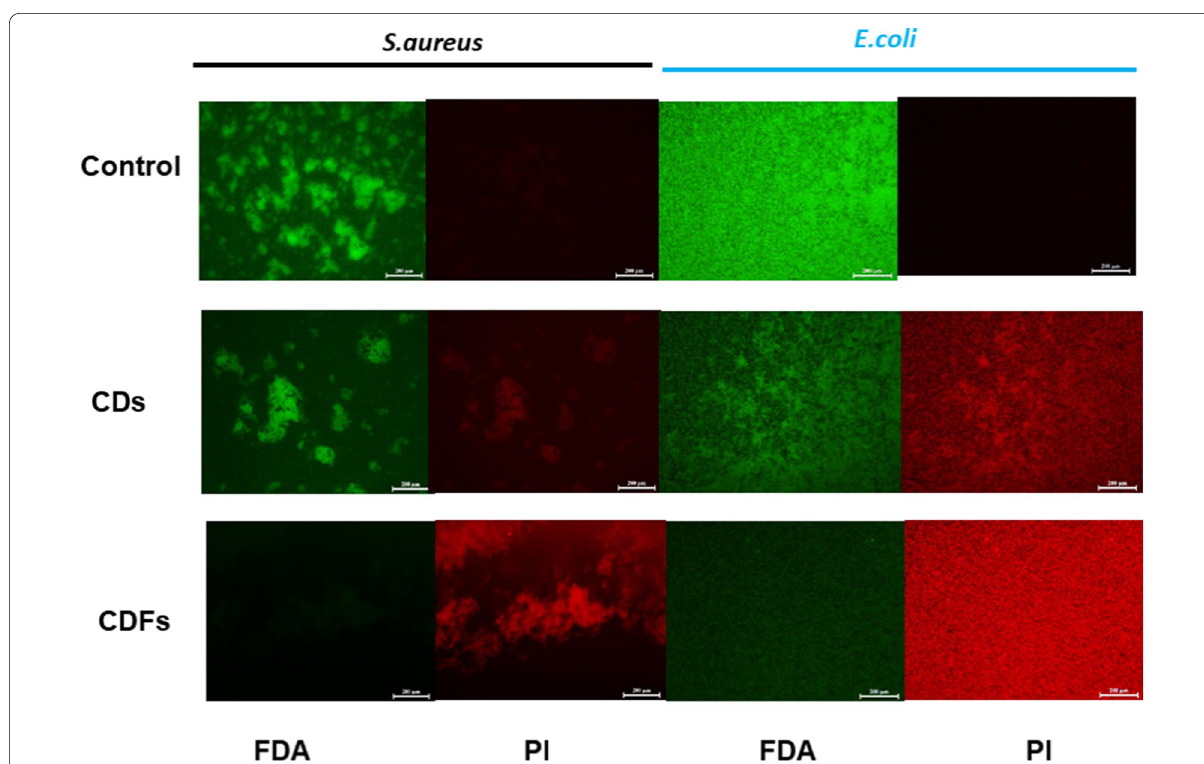
Fig. 7 FDA/PI staining S. aureus and E. coli in the absence and presence of CDs and CDFs at 30 µg/mL. Scale bar, 200